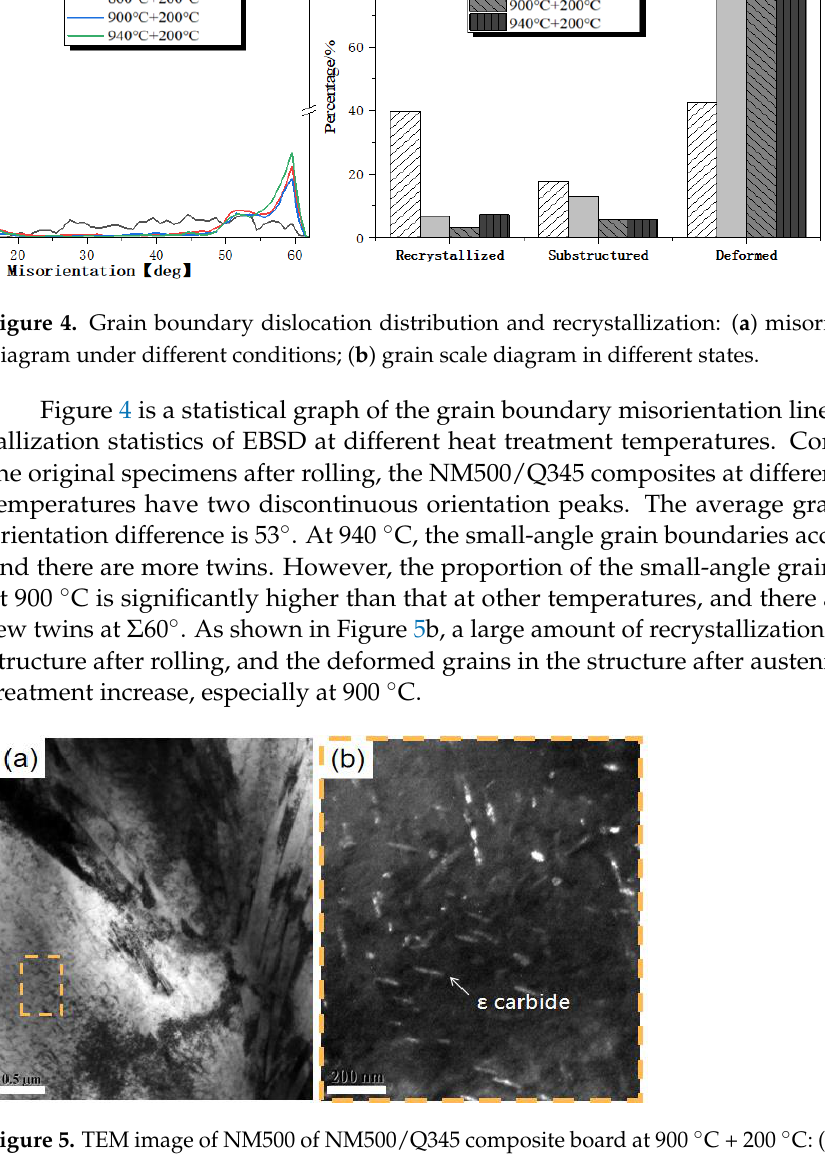
Figure 3. Microstructure IPF of NM500/Q345 composite board in different states: ( a ) original; ( b )